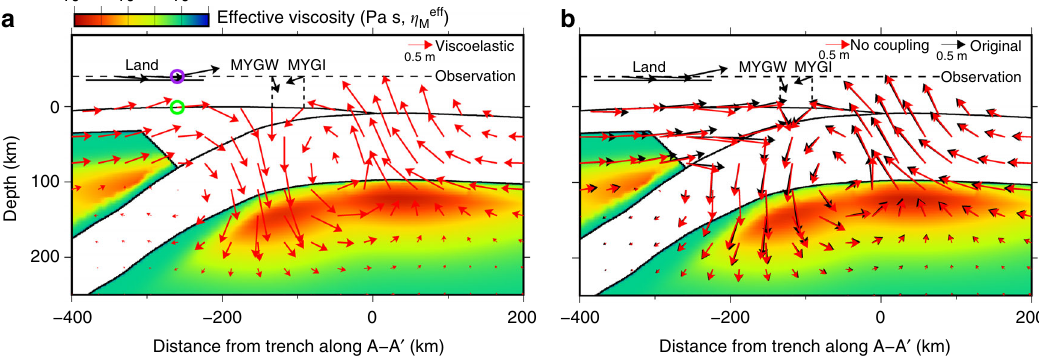
Fig. 8 Displacement without the nonlinear interaction in the A – A ′ pro fi le. a Power-law viscoelastic fl ow in 2.8 years without considering afterslip in the vertical cross-section of the station MYGI and MYGW. In the green circle, uplift is signi fi cantly smaller than in the case with afterslip, shown in Fig. 7a. b Comparison between the total 2.8-year displacement in the original simulation (black, the same as “ total ” in Fig. 7) and the result without interaction between afterslip and viscoelastic fl ow (red). As a result, the computed horizontal displacements are reduced by more than 10% in some of the land stations, and the vertical ones change by more than 30% in many stations in both of the land and the sea fl oor. The color indicates the distribution of effective viscosity in the Maxwell element shortly after the